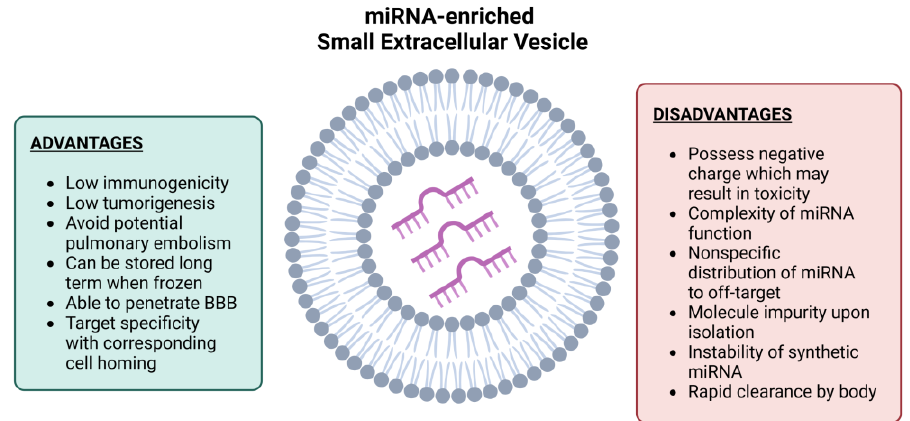
Figure 6. Advantages and disadvantages of miRNA-enriched small extracellular vesicles.